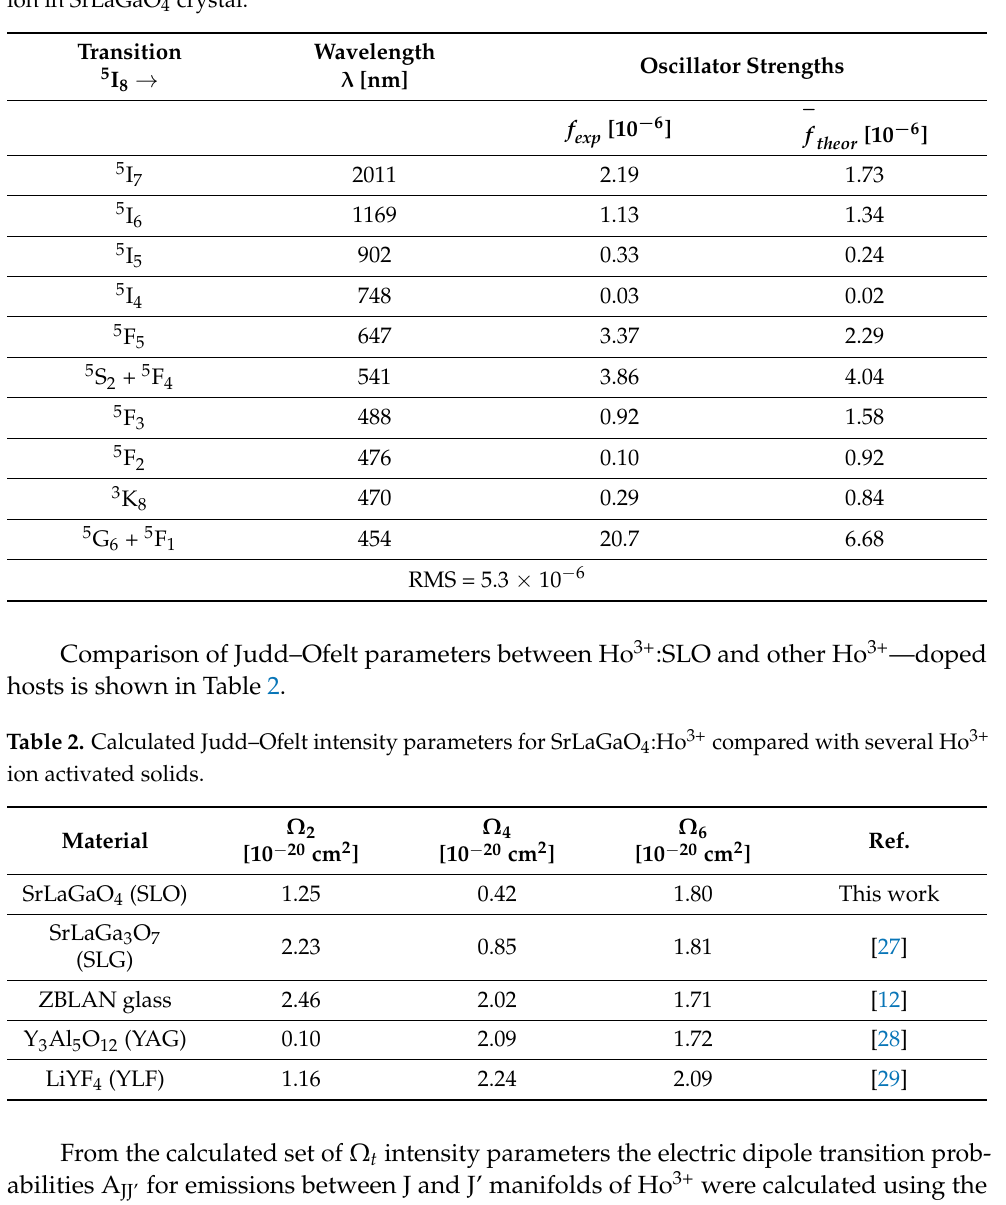
Table 1. Oscillator strengths ( f exp —measured, f theor —calculated) of absorption transitions for Ho 3+ ion in SrLaGaO 4 crystal.